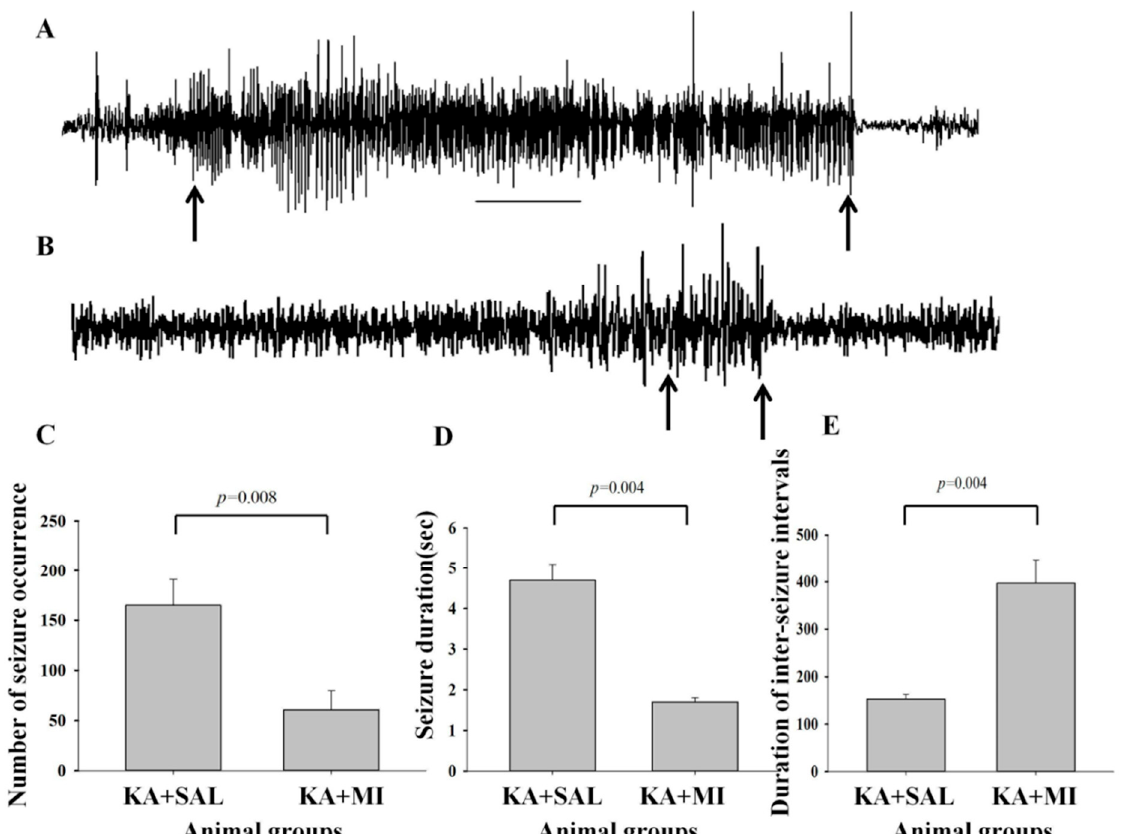
Figure 1. Electrographic seizures in the hippocampus of KA + SAL and KA + MI groups of rats. ( A , B )—typical episodes of electrographic SRS in animals from KA + SAL and KA + MI groups respectively. Black arrows indicate the beginning and the end of the electrographic seizure episodes ( C ) mean number of electrographic SRS; ( D ) mean duration of electrographic SRS and ( E ) mean interval between electrographic SRS. Horizontal bar in A corresponds to 5 s. ( C – E ) On the abscissa is shown group type while on ordinate the characteristic of the electrographic SRS events. The error bars indicate standard error of the mean. ( C ) KA + MI group displayed significantly lower number of the electrographic SRS activity than KA + SAL group ( D )—KA + MI group showed significantly shorter duration of the electrographic SRS than KA group. ( E )—on the ordinate the average duration (sec) of the interval between the SRS events is shown. KA + MI group showed significantly longer intervals between the electrical seizure activity than KA + SAL group. Details of statistical analysis are provided in the manuscript.